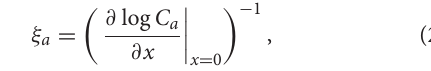
k , indicating that the characteristic length in the system increases with = | |